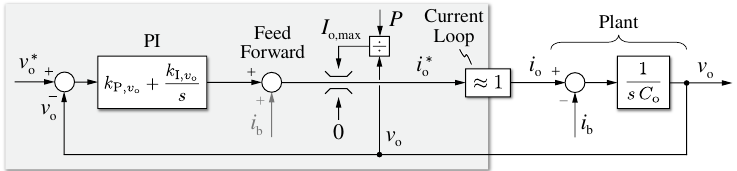
Figure 11. Detailed block diagram of the DC/DC output voltage ( v o ) control